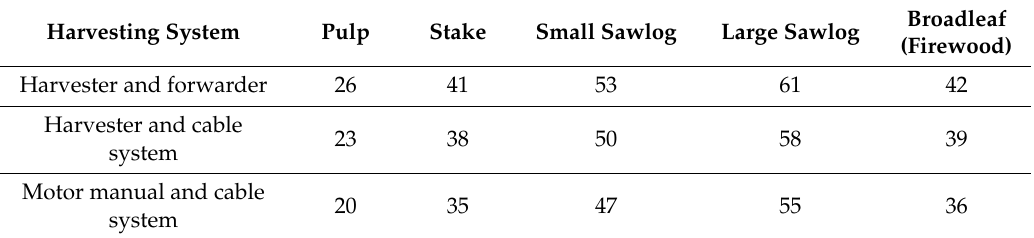
Table 7. Revenue ( € m − 3 ) of each product assortment sold standing for a range of harvesting and extraction practices. The value of a stand depends on the volume of each product assortment. Stake Small Sawlog